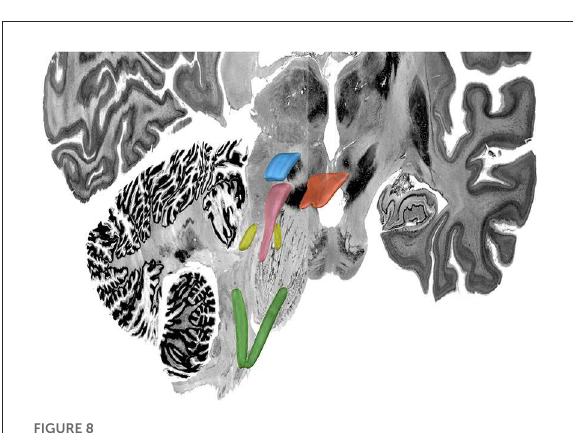
FIGURE8 MNI 3D Atlas. Green: nucleus tractus solitaris; yellow: locus coeruleus; pink: periaqueductal grey; blue: ventral tegmental area; orange: dorsal raphe nucleus. For this figured, Lead-DBS was used to visualize the same volumetric MNI seed masks as shown in Figures 3–7 which are here overlaid on the MNI template brain to provide a 3-D representation of the relationship between these brainstem